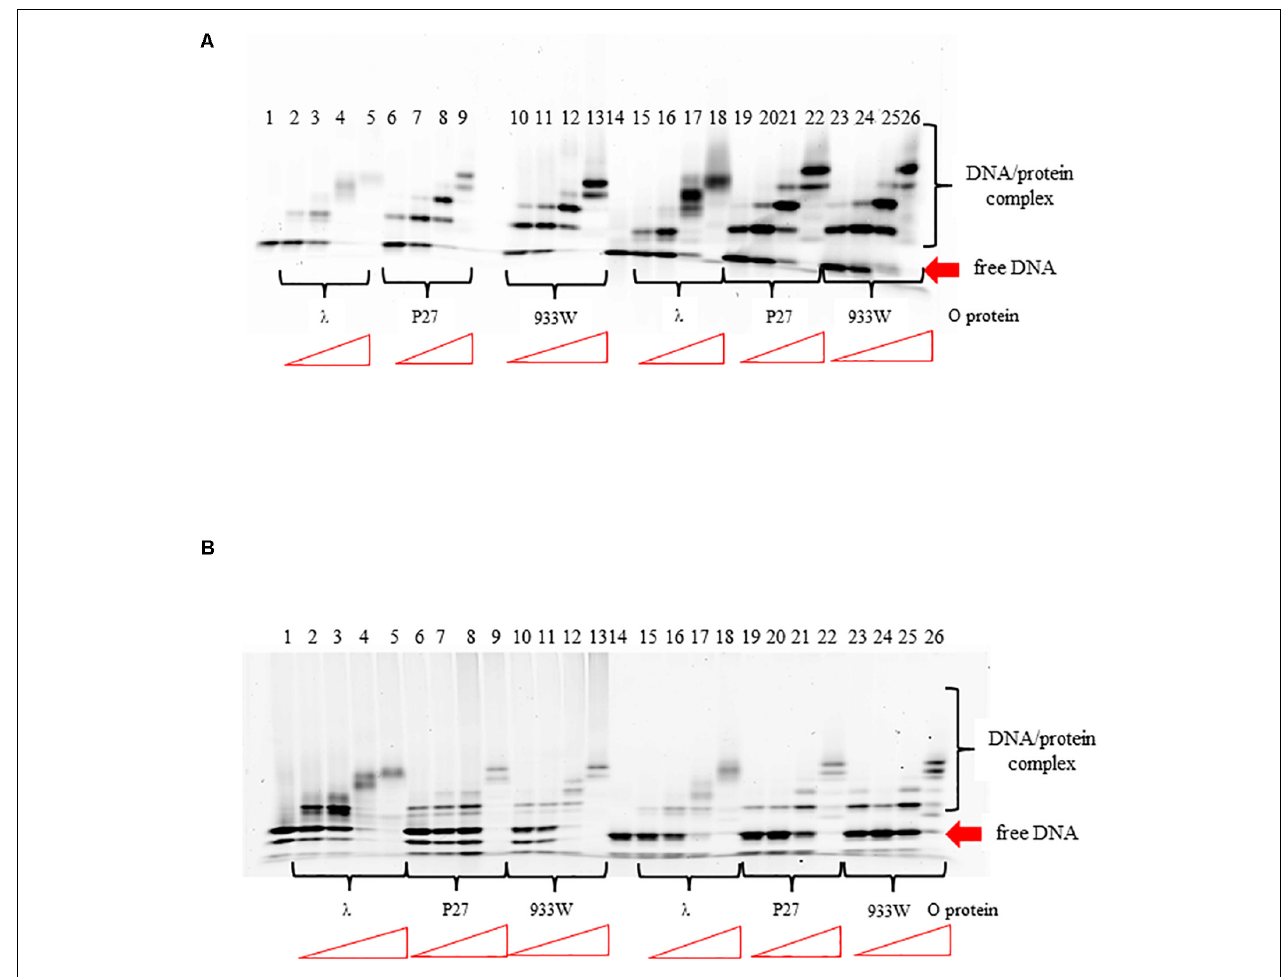
FIGURE 7 | Interactions of O proteins of phages λ , P27 and 933W with DNA templates containing four panel (A) or six panel (B) iterons together with the AT-rich region (lanes 1–13) or the AT-rich region replaced with a sequence contained 57% of GC base pairs (lanes 14–26), as assessed by EMSA. Increasing molar ratios of DNA:O proteins, indicated in particular wells, were as follows: 1:2, 1:4, 1:8, and 1:16. Lanes no. 1 and 14 contain no O